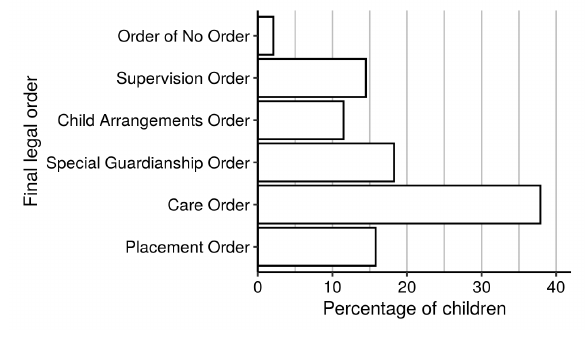
Figure 5: Legal outcomes for children in public family law proceedings in 2017/18 and how they relate with the age of the child. (a) Percentage of children receiving specific final legal or- ders in 2017/18.